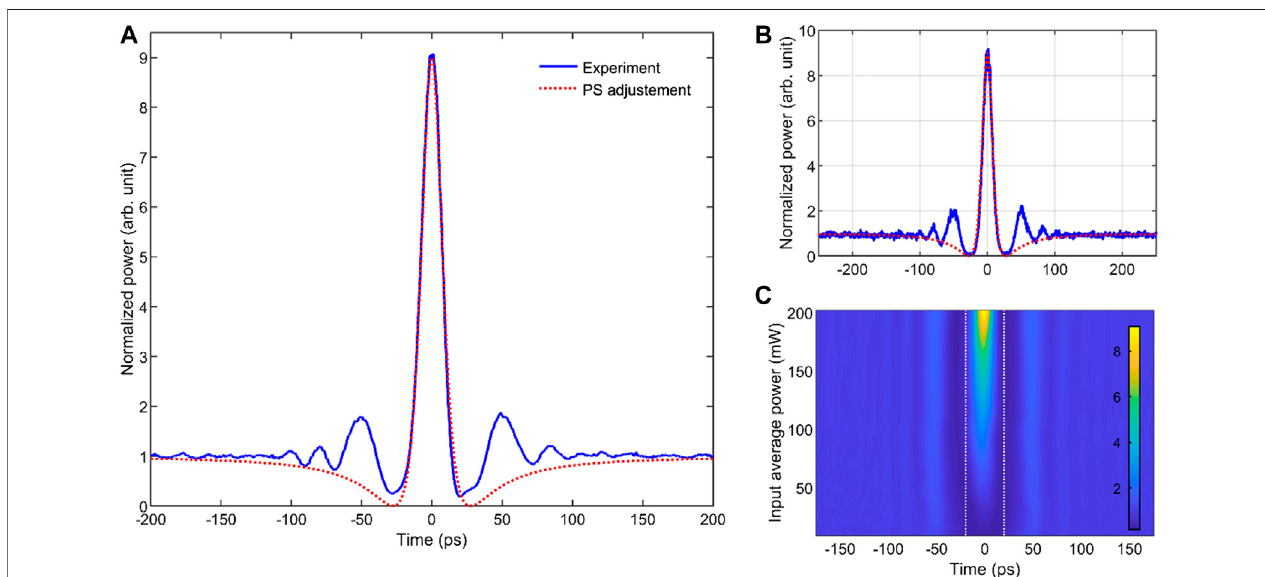
FIGURE2|(A) Experimental output temporal pro fi lerecordedontheESO (blueline) compared with a fi tbythePSwaveform ( Eq. 2 ,red dotted line).Input average power is23 dBm. (B) Sameas (A) butrecordedontheOSO. (C) Evolutionofthetemporalintensitypro fi leaccordingtotheinputpower. Intensitypro fi lesarenormalized by the intensity of the output continuous background. The white dashed line indicates the temporal location of the sharp edges of the input waveform.